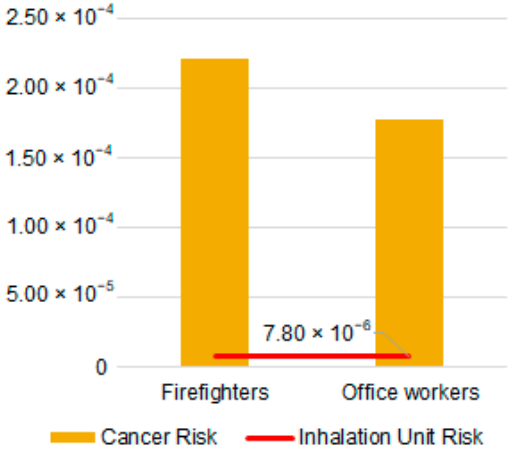
Figure 3. Cancer risk assessment results for exposure to benzene for various groups of fire service